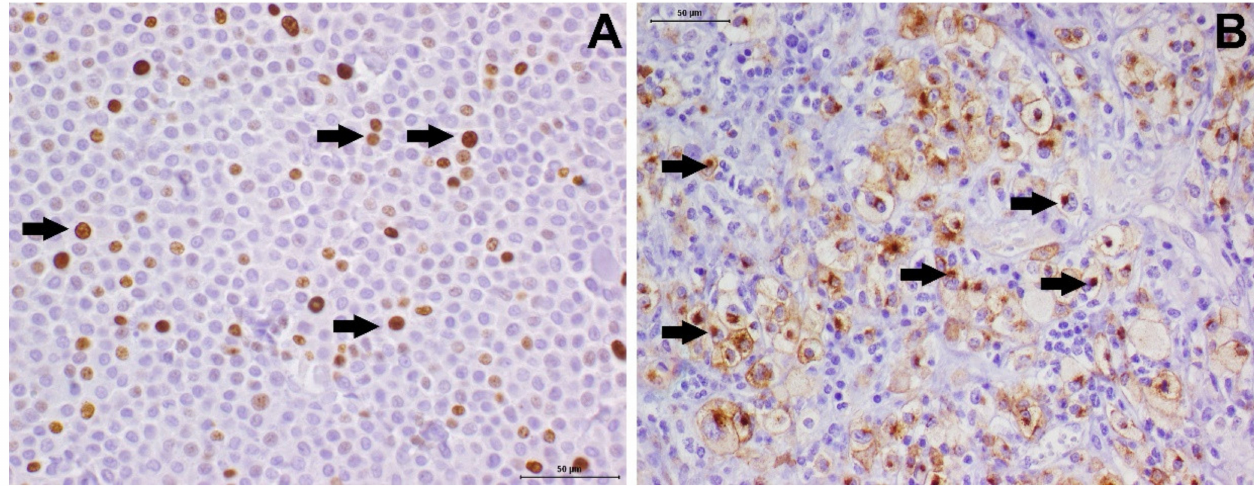
Figure 4. Ki67 and KIT immunoexpression in canine mast cell tumors. ( A ) Ki67 expression in a mast cell tumor showing more than 23 positive cells (arrows–brown staining). ( B ) KIT immunohistochem- istry revealing pattern II (focal cytoplasmic–arrows). Harris hematoxylin counterstaining. For KIT, studies have determined three patterns of protein expression in canine MCTs: the membranous pattern (KIT pattern 1), focal cytoplasmic pattern (KIT pattern 2) (Figure 4B), and diffuse cytoplasmic pattern (KIT pattern 3) [79,106]. The different